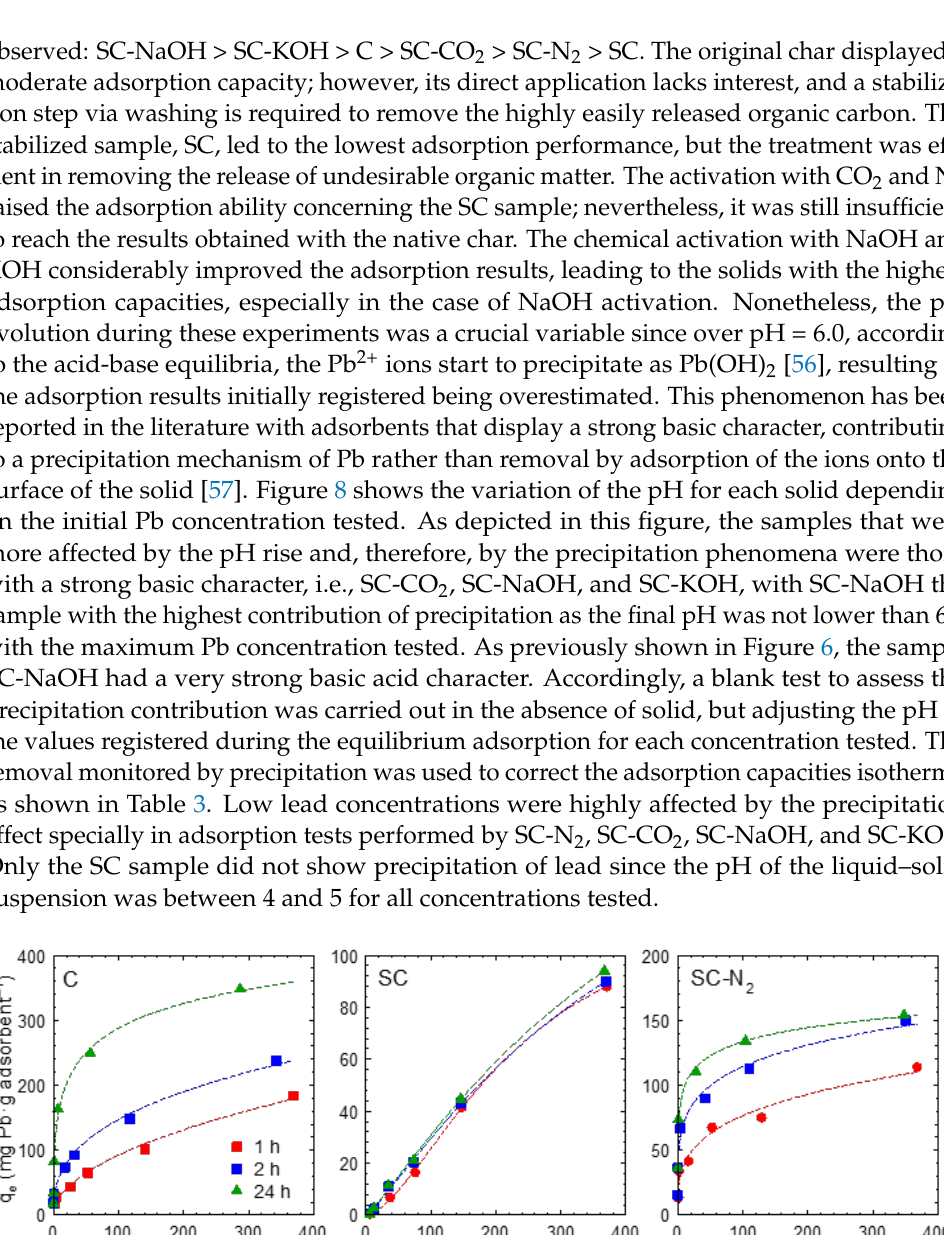
Figure 8. Evolution of the adsorption equilibria pH with the initial concentration of Pb.